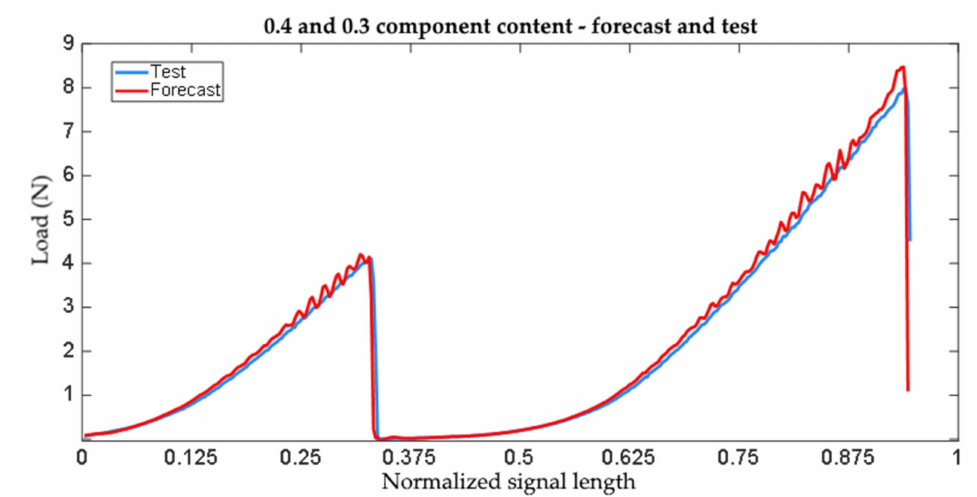
Figure 14. Comparison of the forecast quality to the experimental test values. Based on the characteristics produced, differences in the maximum breaking forces were determined between the heat-held cured joints and the ambient temperature-cured joints. The result was the node points with the coordinates which denoted the values of the differences between the maximum breaking forces. The zero crossings were determined by interpolation. This process was applied separately for the values from the experimental tests and the forecasts. Examples of the interpolation results are shown in Figure 15